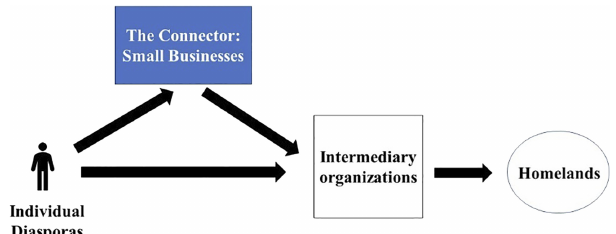
Figure 1. Role of small businesses as the